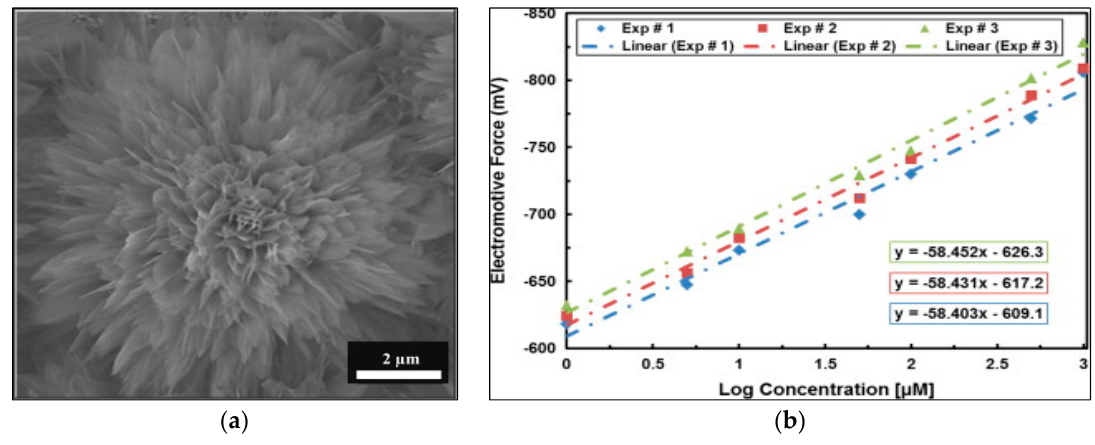
Figure 3. ( a ) SEM image of three-dimensional ZnO dahlia-flowers. ( b ) Repeated calibration curves for the cholesterol biosensor against a standard Ag/AgCl reference electrode [24].